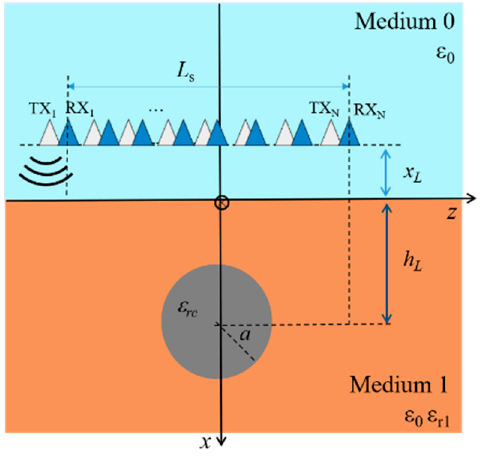
Figure 3. Geometry of the scanning layout with a set of N transmitters (RX i , i = 1, …, N ) and N receivers (TX i , i = 1, …, N ) along the scanning length L s .